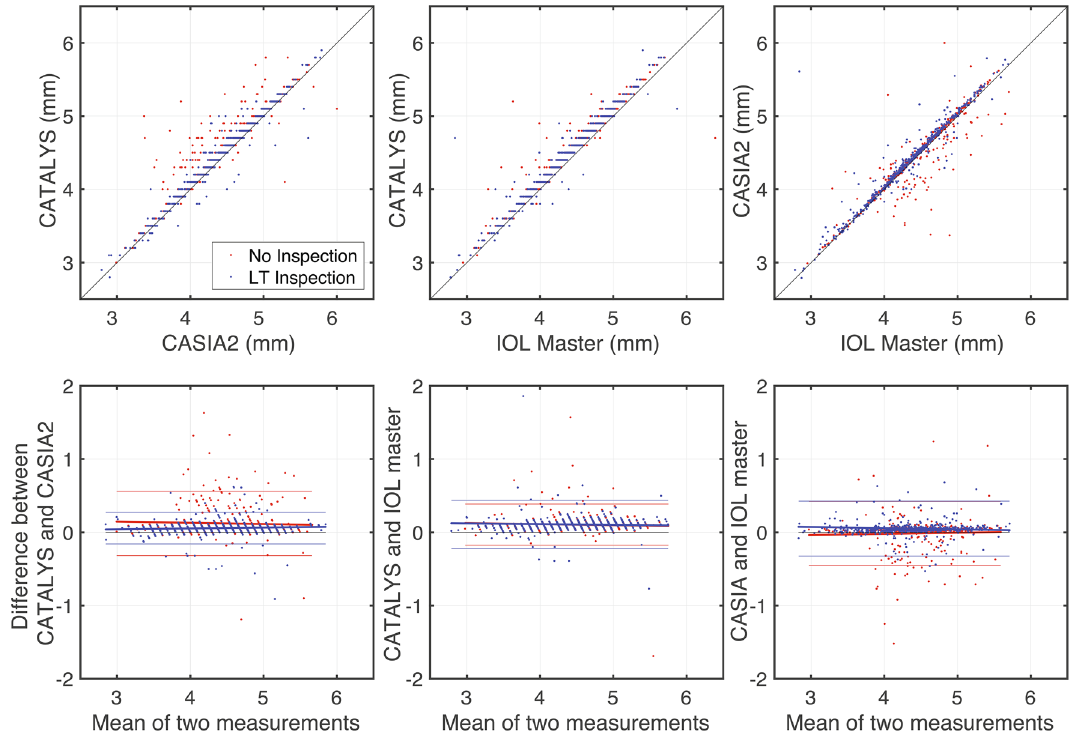
Figure 3. Comparison of the lens thickness measured by pre- and intra-operative OCT. The upper row of figures shows scatter plots comparing two measurements. The lens thickness by three different measurements are highly correlated. In the No inspection group (red dots), the lens thickness with CATALYS tends to be longer than those of CASIA2. However, the LT inspection reduces the differences between the lens thickness measured by CATALYS and CASIA2 (blue dots). The lower row of figures shows Bland—Altman plots. Red and blue dots indicate each measurement of the No inspection group and the LT inspection group, respectively. Most measurements exist between two of the thin solid lines, which indicate confidence intervals for 95% limits of agreement. Thick solid lines indicate the linear regression line. The LT inspection reduced the difference between the lens thicknesses as measured using CATALYS and CASIA2 (lower left panel). The lens thickness as measured using CATALYS is greater than that measured using IOL master, regardless of LT inspection (lower middle